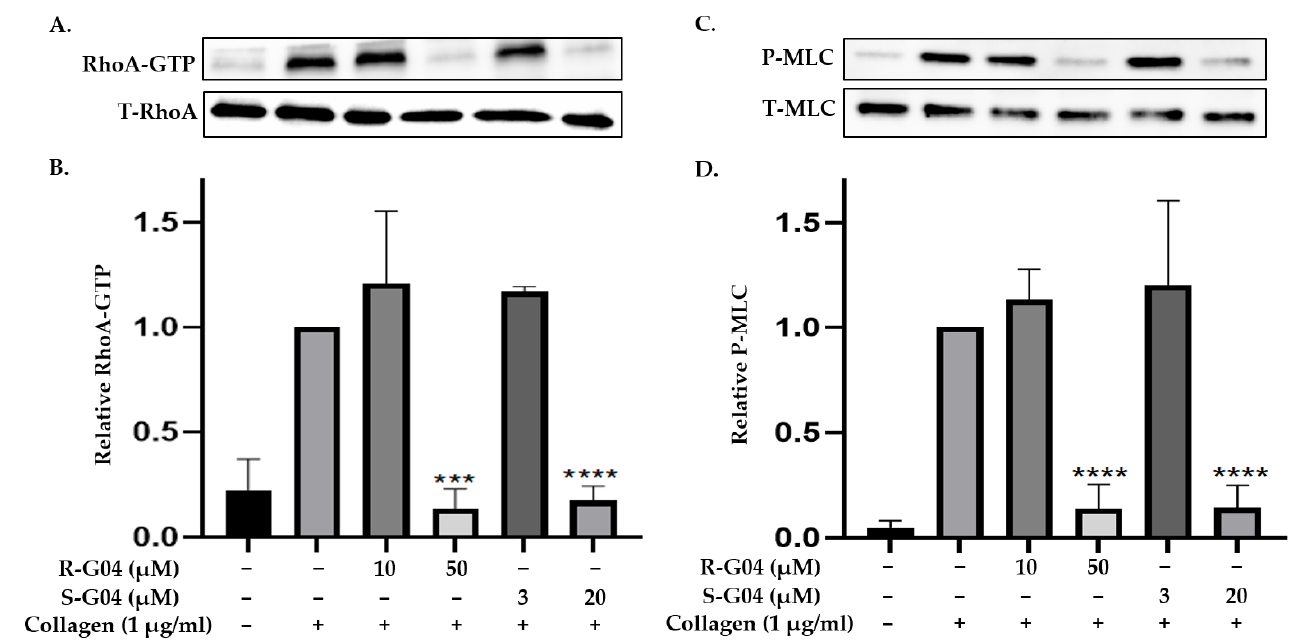
Figure 5. R-G04 and S-G04 inhibit the activation of RhoA and phosphorylation of the myosin light chain . ( A , B ) Washed human platelets were incubated with collagen (1 µg/mL) for 4 min, and the levels of RhoA-GTP formation were quantified with GST-Rhotekin effector pull-down assay. Platelets were pre-incubated with R-G04 (10 µM or 50 µM) or S-G04 (3 µM or 20 µM) for 2 min before being stimulated with collagen, and the addition of ice-cold lysis buffer terminated the reaction. Both R-G04 and S-G04 inhibited RhoA-GTP formation in a concentration-dependent manner. The total cell lysates were also blotted in parallel. Relative amounts of the GTP-bound form of RhoA were quantified with densitometry measurements of total RhoA (T-RhoA) and normalized to untreated platelets. ( C , D ) The addition of different concentrations of R-G04 or S-G04 to washed human platelets 2 min before stimulation with collagen (1 µg/mL) blocked the phosphorylation of the myosin light chain (MLC). The reactions were terminated after 4 min by adding 4x Laemmli sample buffer. The samples were processed for Western blotting and probed for MLC and p-MLC, and phosphorylation was quantified by measuring the densitometry of total MLC (T-MLC). The differences among the DMSO, R-G04, and S-G04 were analyzed using t -test, and the results are shown as means ± SDs of three independent experiments. (*** p < 0.001 and **** p < 0.0001).